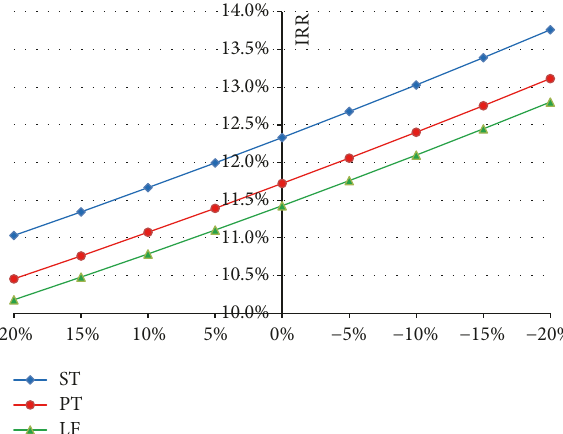
Figure 4: The sensitivity analysis results of the IRR of CSP to the interest